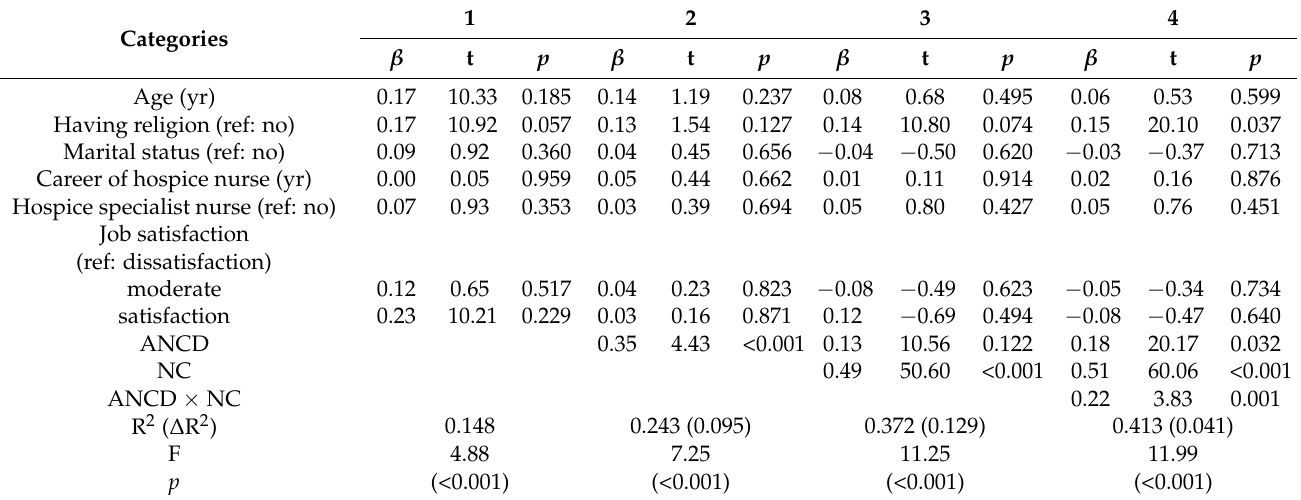
Table 3. Moderating effect of NC on the relationship between ANCD and performance of terminal care ( n =